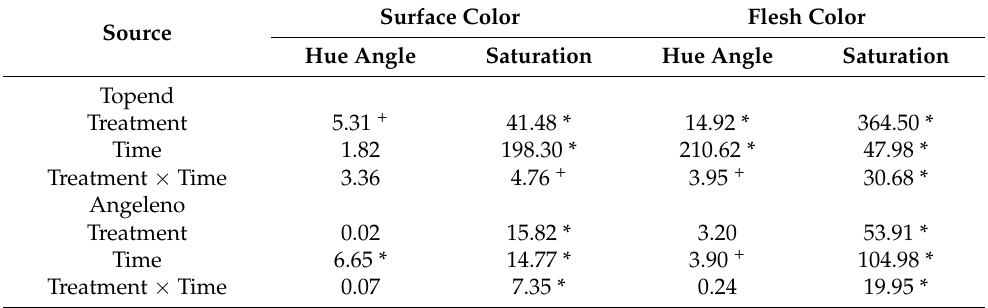
Table 4. ANOVA F values of 1-MCP treatment and storage time on color by cultivars. Surface Color Flesh Color Source Hue Angle Saturation